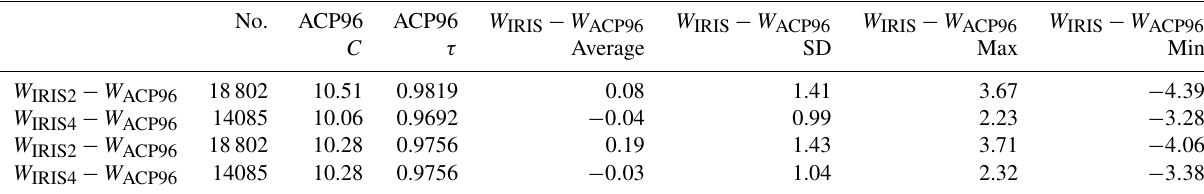
Table 5. The statistics of ( W IRIS − W ACP96 ) using ε c = 0 . 0225 and γ = 6 . 5 from March to November 2020, for pairs of C and τ that minimised the standard deviation of ( W IRIS − W ACP96 ). The difference statistics using the average C and τ of the IRIS2 and IRIS4 results are also given in the last two rows of the table. No.